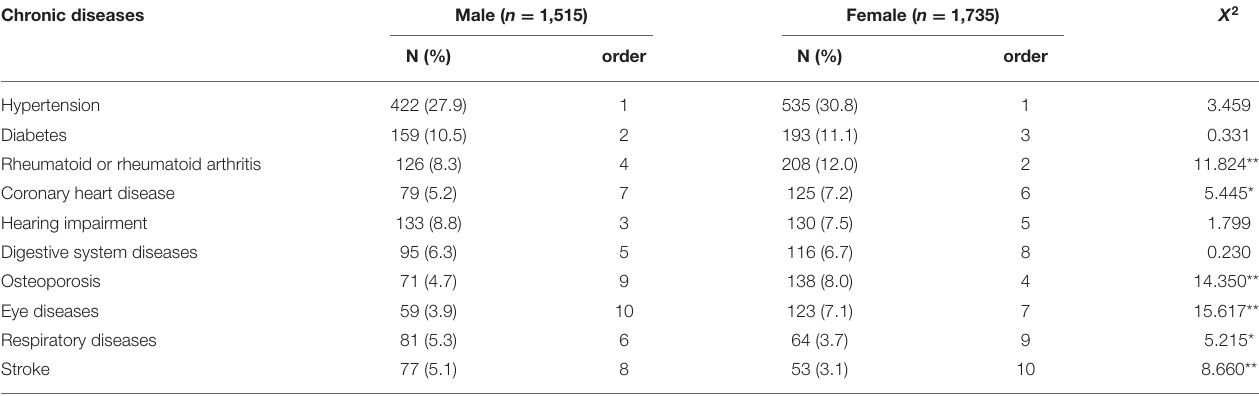
TABLE 2 | The gender differences of the 10 most prevalent chronic diseases among older adults. Chronic